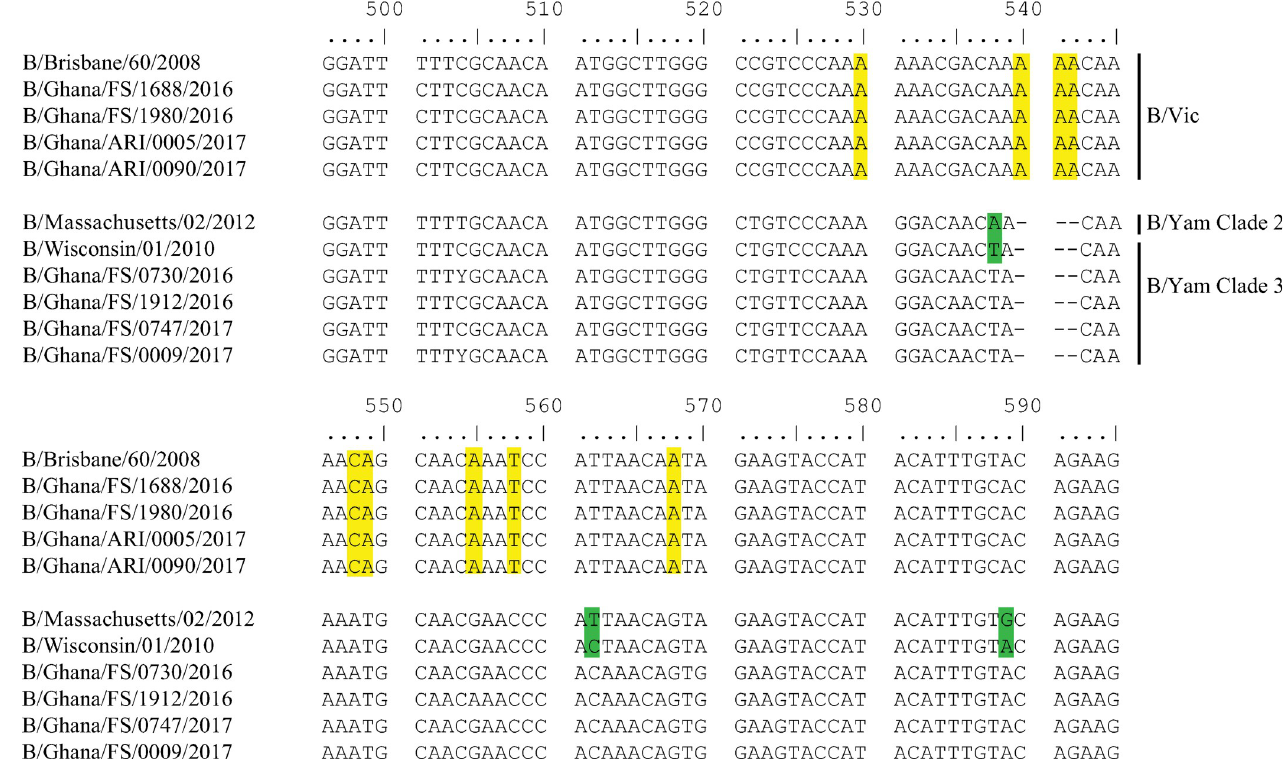
Fig 2. Lineage specific markers of influenza B HA gene. Multiple sequence alignment was carried out using ClustalW in BioEdit with a boostrap replicates of 1000 in line with Edgar [16]. Influenza B/Brisbane/60/2008 was used as the reference sequence for B/Victoria lineages while B/Wisconsin/1/2010, Clade 3 and B/Massachusetts/2/2012, Clade 2 were used as the reference sequence for B Yamagata lineages. Influenza B virus lineage-specific markers (nts 522, 540–542, 548, 549, 555, 558 and 568) are shown in yellow, whereas the clade specific markers (nts 538, 562 and 589) have been highlighted as green.